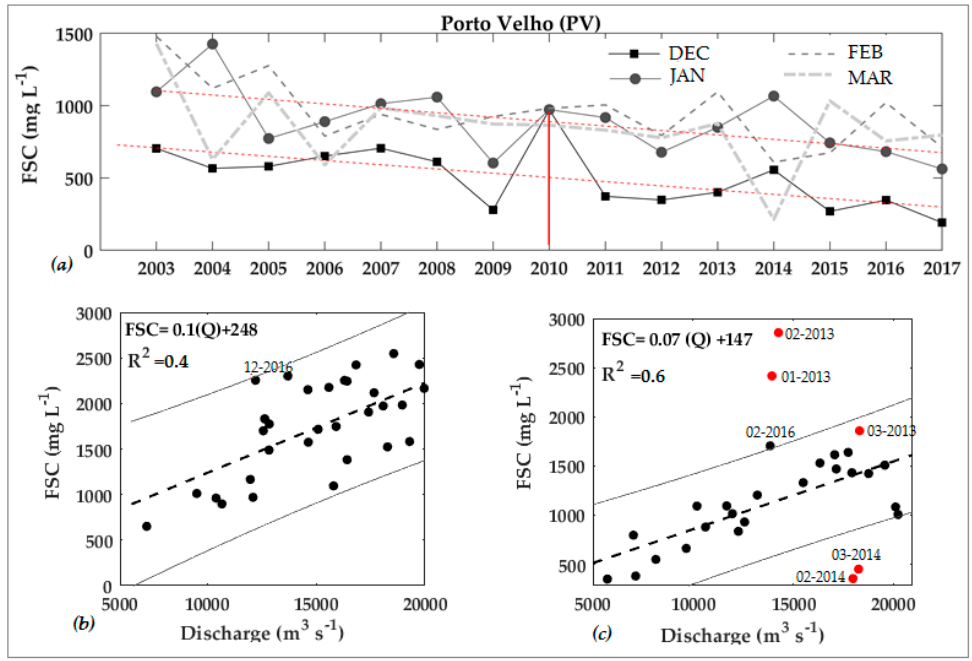
Figure 6. ( a ) The monthly FSC time series at PV in the Madeira River from December to March (only the December and January series with significant trends have their linear trends graphically represented as red dashed lines). The vertical line in 2010 separates the period of change in the average FSC during December and January. Water discharge and FSC during DJFM at CE in the Beni River ( b ) for 2003–2010 and ( c ) for 2010–2017 (without JF 2013 and FM 2014). The dashed black line represents the linear relationship. Black lines represent the 95%